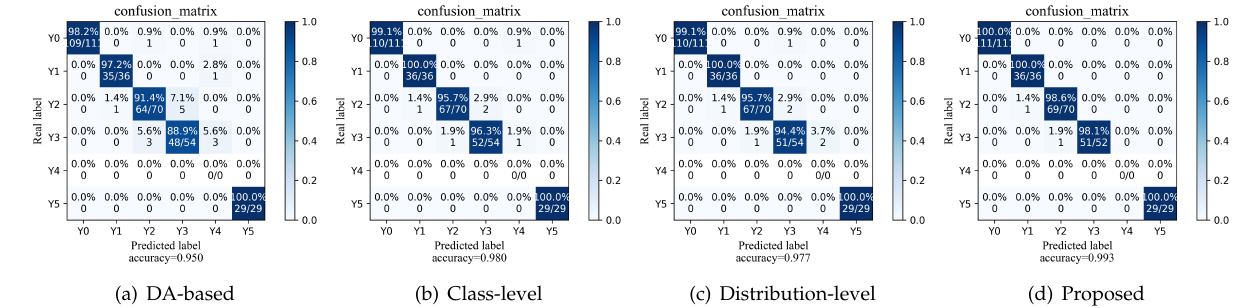
Figure 14. Ablation study to the partial domain adaptation